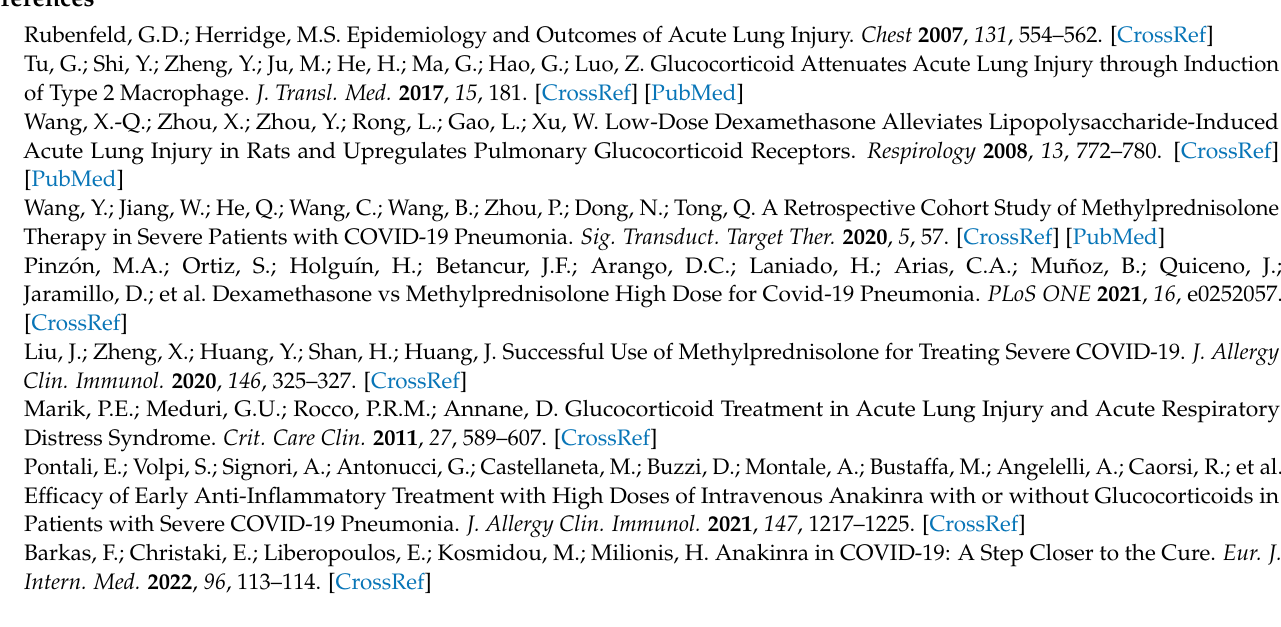
Figure S5 : 1 H NMR (400 MHz, CDCl 3 ) and 13 C NMR (100 MHz, CDCl 3 ) spectra of 9e, Figure S6 : 1 H NMR (400 MHz, DMSO- d 13 C NMR (100 MHz, DMSO- d 1 H 6 ) and 6 ) spectra of 9f, Figure S7 : NMR (400 MHz, DMSO- d 6 ) and 13 C NMR (100 MHz, DMSO- d 6 ) spectra of 9g, Figure S8 : 1 H NMR (400 MHz, CDCl 3 ) and 13 C NMR (100 MHz, DMSO- d 6 ) spectra of 10f, Figure S9 : 1 H NMR (400